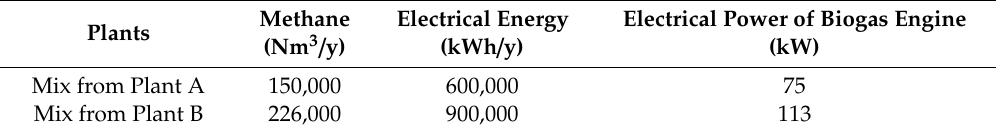
Table 6. Preliminary technical